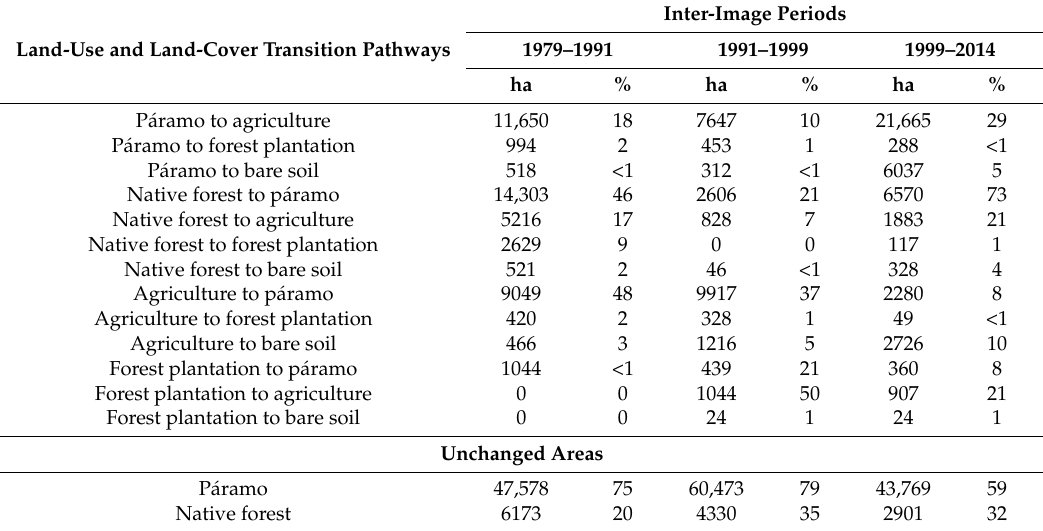
Table 3. Major land transitions in the Chambo river between 1979 and 2014 by area (ha) and as a proportion of the class at the start of the inter-image period. Wetlands are